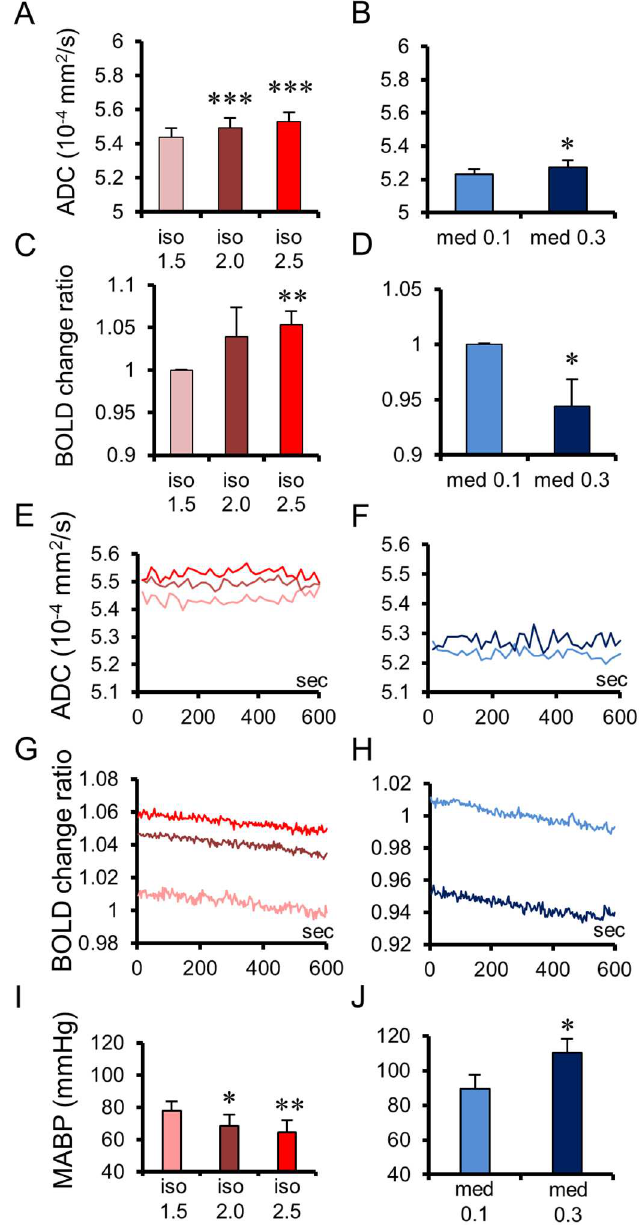
Fig 2. Apparent Diffusion Coefficient (ADC) and Blood Oxygenation Level—Dependent (BOLD) changes and time courses for each dosage of both anesthetic conditions. Averaged ADCs of whole brains for each dosage of isoflurane(A; n = 10) and medetomidine (B; n = 8). AveragedBOLD signal change ratios of whole brain for each dosage of isoflurane (C; n = 6) and medetomidine (D; n = 7). Averagedtime courses of ADCs (E, F) and BOLD signalchanges ratios (G, H) at wholebrains for each dosageof isoflurane (E, G) and medetomidine (F, H), showingthe stability of the ADC changewhile the BOLD signal exhibits a significantnegativedrift with time. Note that the BOLD changelevels for each medetomidine dosage are invertedbetweenE and H. Mean arterial blood pressure (MABP) under each dosageof isoflurane (I; n = 5) and medetomidine (J; n = 5). Bar plots exhibit mean ± standarderror of the mean (SEM). * p < 0.05, ** p < 0.01, *** p < 0.001 (Paired t -test, versus low dose of each anesthesia). Data for wholebrains of individual rats can be found in S1 Data for ADC and S2 Data for BOLD. MABP data of individual rats can be found in S4